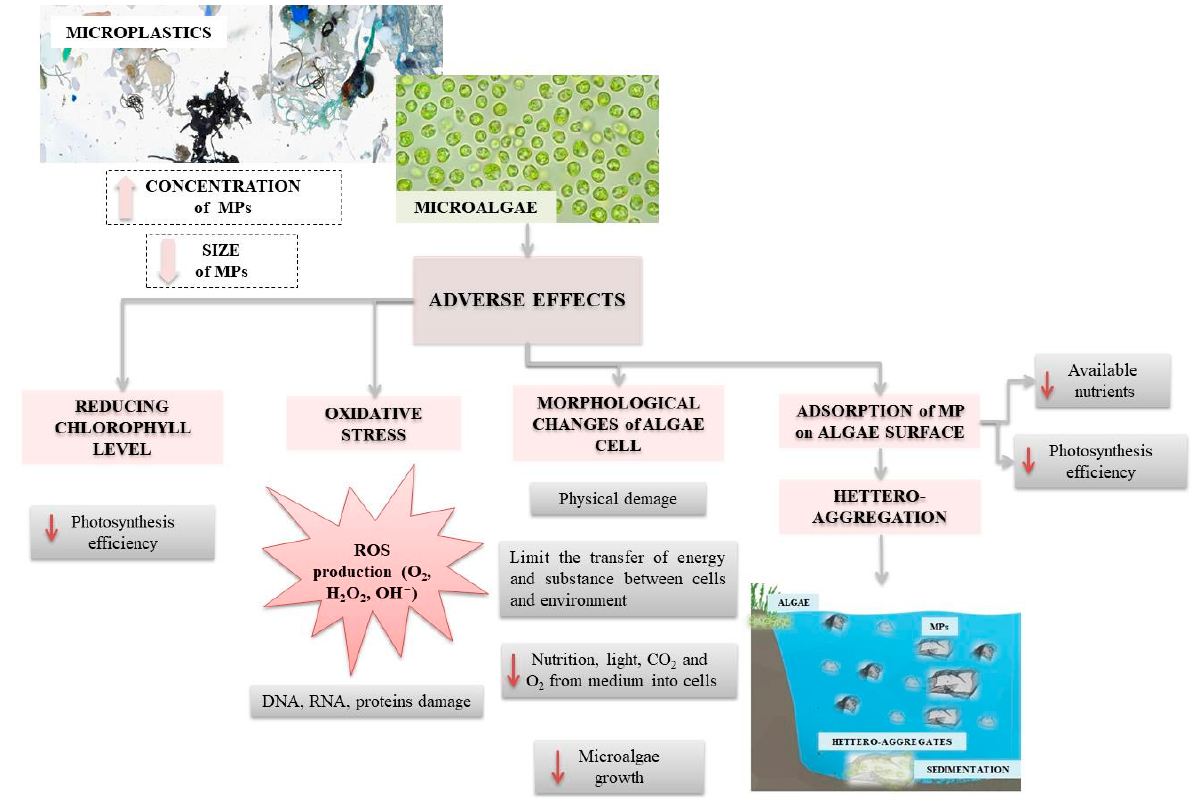
Figure 4. Effects of microplastics on microalgae.